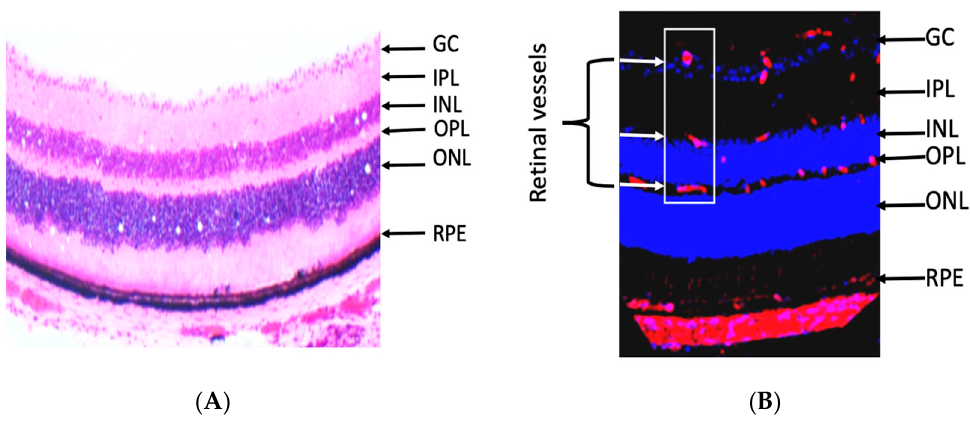
Figure 3. ( A ) Retinal section, which was isolated from mice, stained with hematoxylin and eosin showing different retinal layers as seen under the microscope from inside to outside are the ganglion cell (GC), inner plexiform (IPL), inner nuclear (INL), outer plexiform (OPL), outer nuclear (ONL), and retinal pigment epithelium (RPE). ( B ) Immunostaining of retinal section (mouse) with the vascular marker (isolectin-B4, red) and nuclear marker (DAPI, blue), showing that retinal blood vessels (inside the white box) are primarily localized in the inner retinal layers (the nerve fiber and ganglion cell layer and plexiform layer). The arrow in B is pointing to inner retinal layers that contain blood vessels (red).